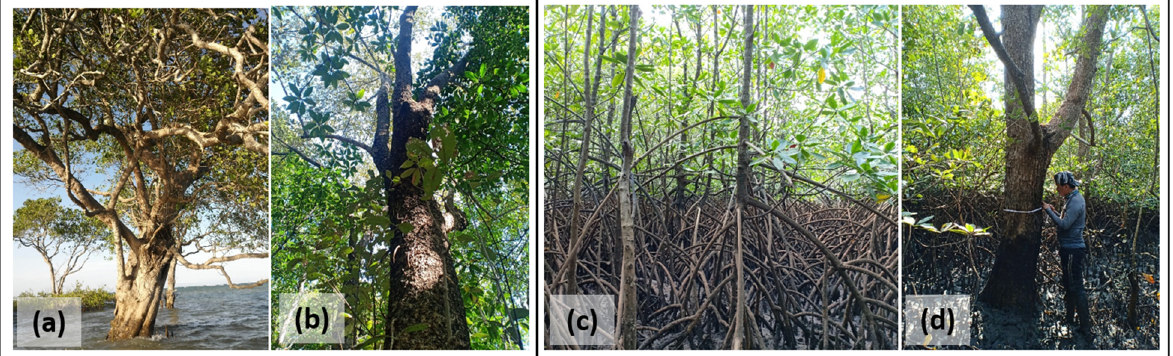
Figure 7. The total aboveground biomass per species in the natural mangrove forest and the refor- estation site.